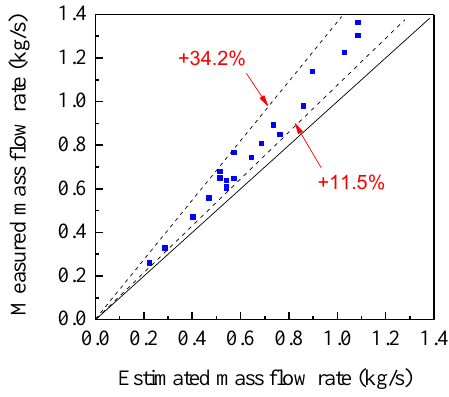
Figure 16. Comparison of the measured mass flow ratewith the estimated value.